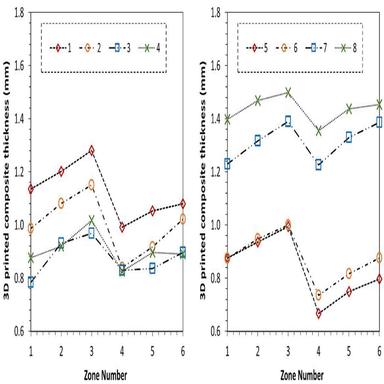
Thickness variation of 3D printed magnetic composite samples across six printing zones (as designated in) on the build head; Legend indicates experiment numbers 1 to 8 as indicated in 1; (Left) Experiment 1 to 4, (Right) Experiment 5 to 8.